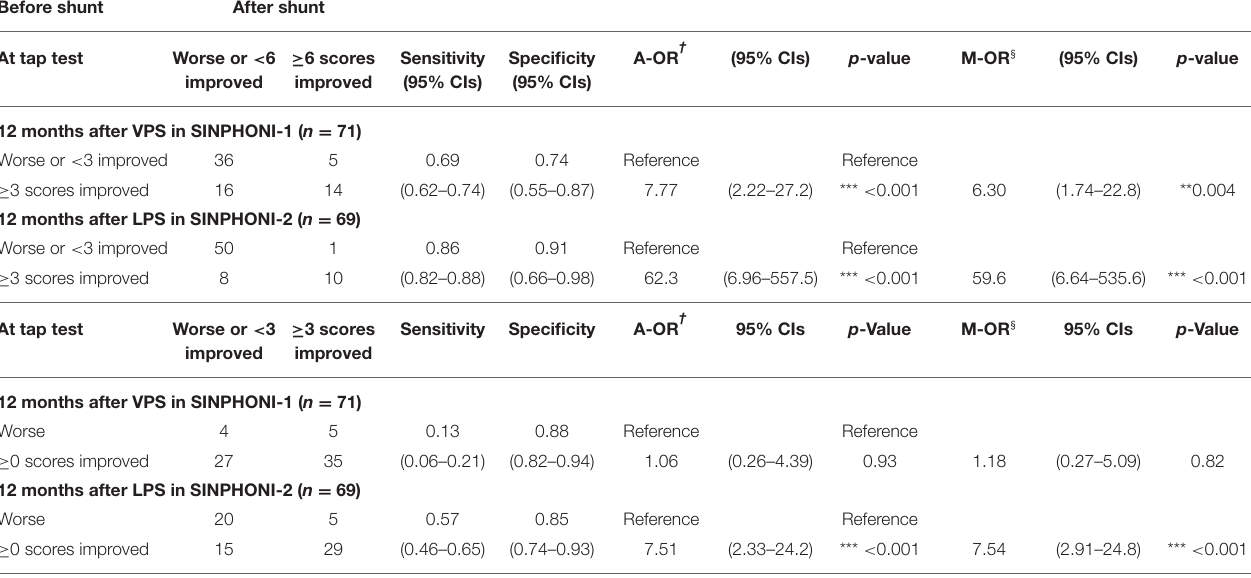
TABLE 2 | The odds ratio for improvement of scores on MMSE after shunt surgery. Before